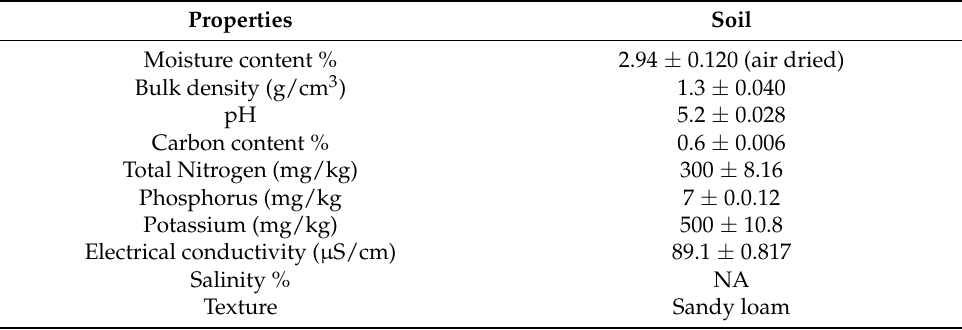
Table 1. Physicochemical proprieties of the